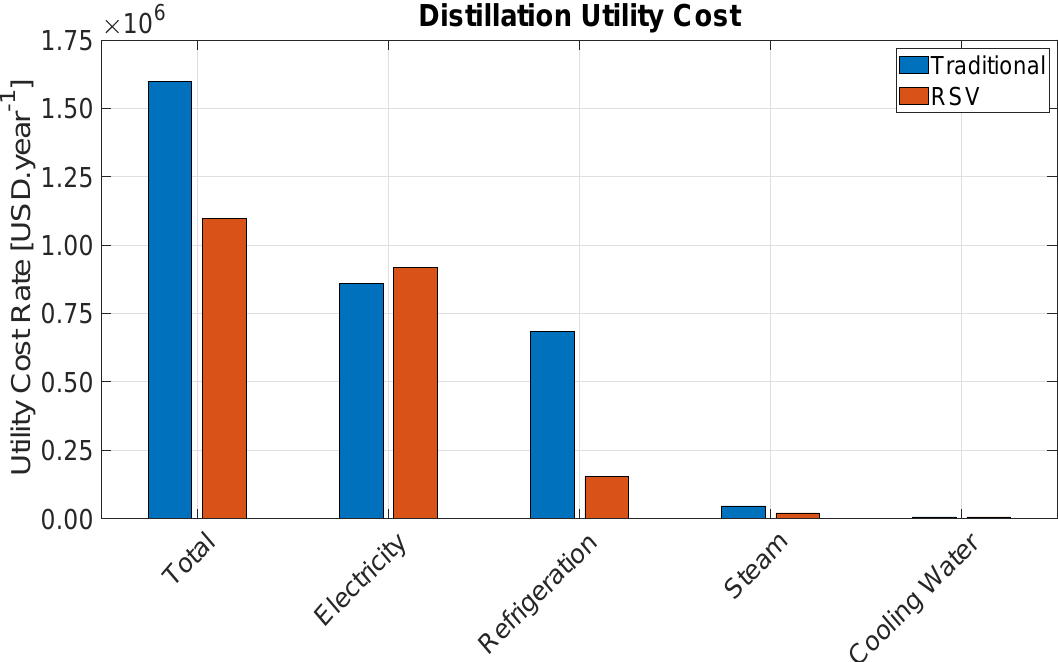
Figure 13. Cost rates of different utility in the distillation section for the two compared process configurations. Reproduced with permission from Penteado, Ph.D. Thesis, TUB, 2021